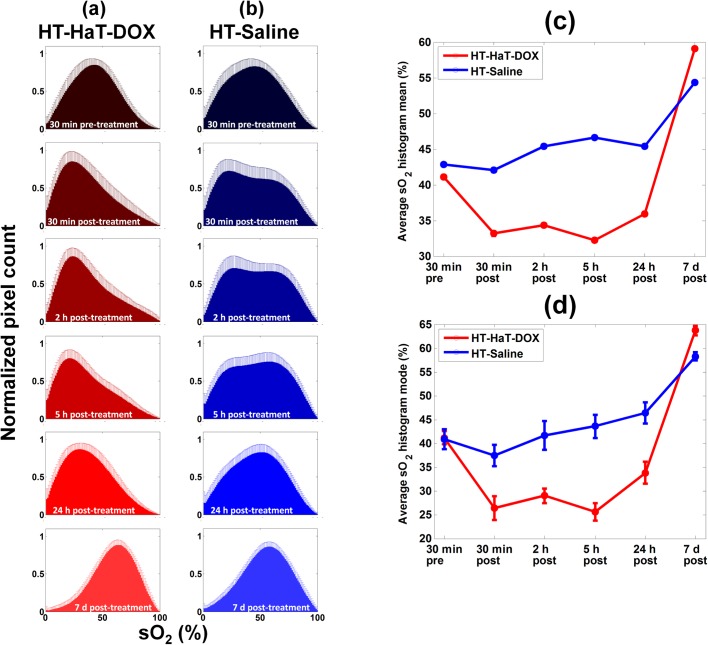
Oxygenation histograms.(a) Average sO2 histograms at 30 min pre-treatment and 30 min, 2 h, 5 h, 24 h and 7 day timepoints post-treatment for HT-HaT-DOX (n = 12) and HT-Saline (n = 15). Two timecourses have been plotted to compare the treatments studied using the mode (b) and mean (c) averages of the histogram data plotted in (a) relative to their starting values at 30 min pre-treatment. Error bars represent the standard deviation on the pixel count for each sO2 value from each mouse which had 21 different histograms per imaging timepoint. The black arrows represent the points at which the treatments were made (i.e. defined in this plot as 0 h). Datapoints that show a drop in sO2 which is significantly different to pre-treatment are represented by * where p < 0.05.